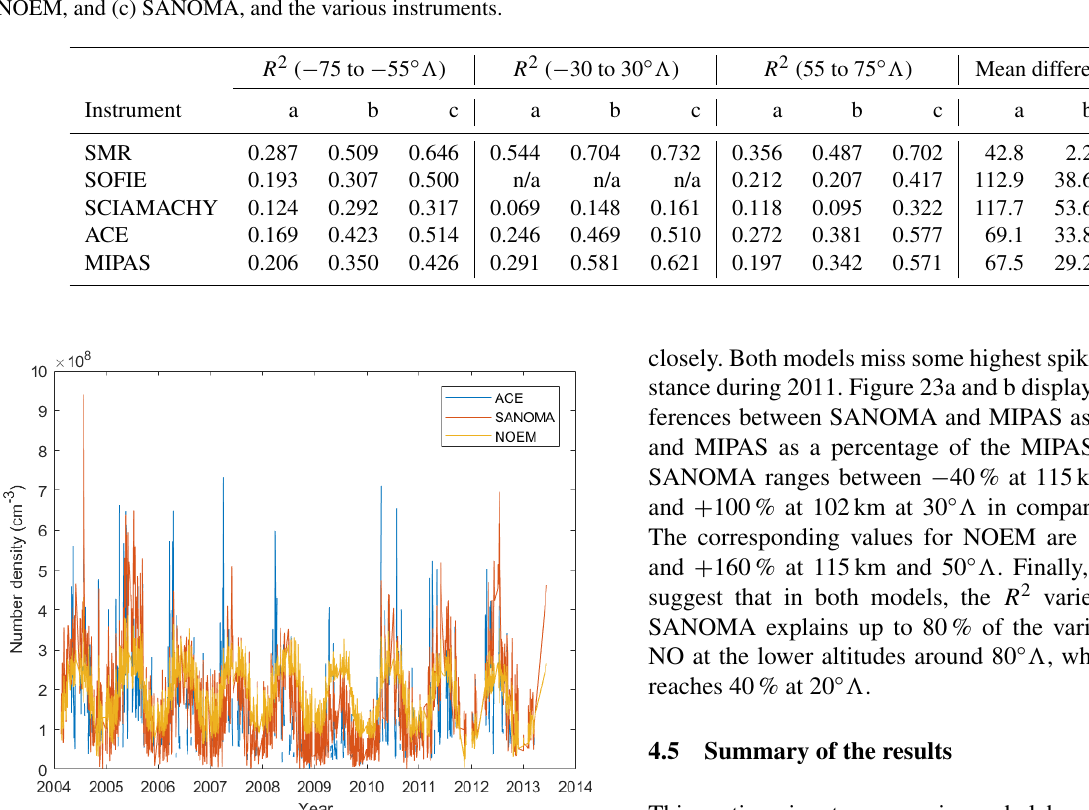
Table 3. Adjusted R 2 averaged over the entire altitude range (102–115km) over three latitude bands: southern high latitudes, tropics, and northern high latitudes, as well as the average of the mean percentage differences over these three domains between (a) NOEM, (b) SMR- NOEM, and (c) SANOMA, and the various instruments.